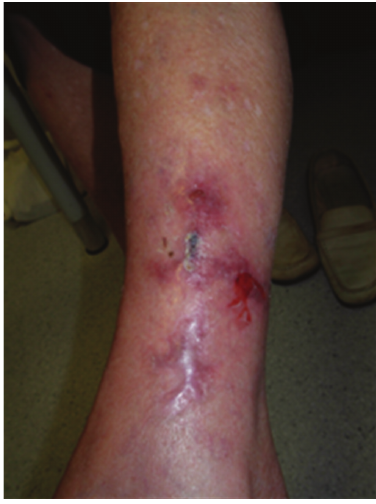
Figure 2: Successfully healed calciphylaxis following autolytic debridement and dressings along with treatment with cinacalcet and prednisolone in patient 4 who later died of myocardial